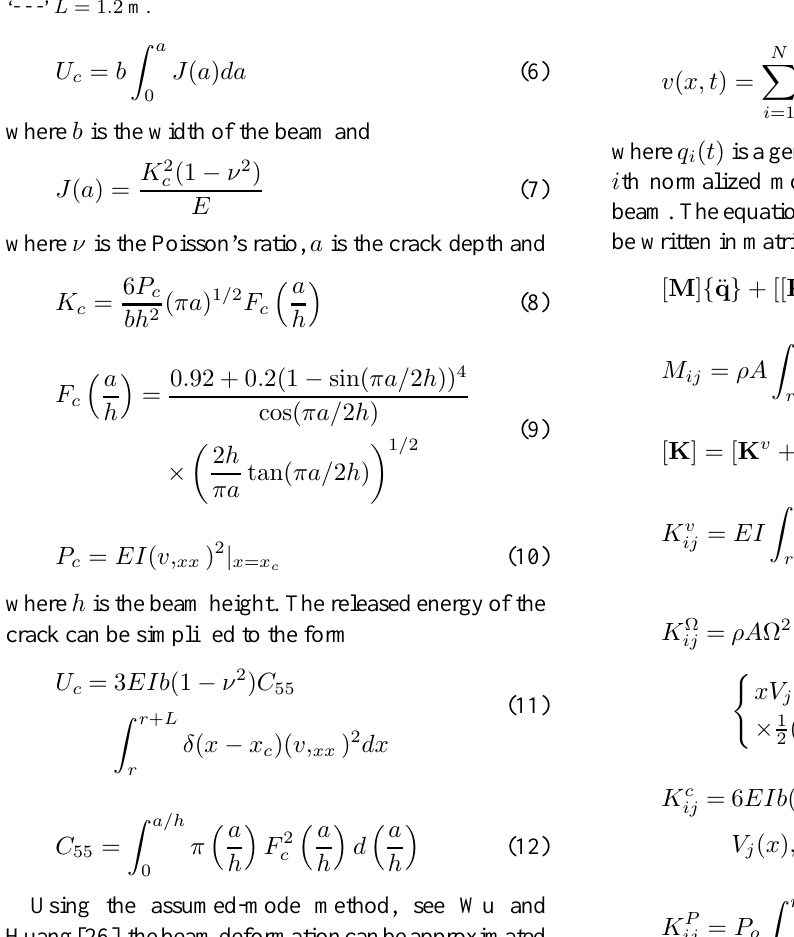
Fig. 2. First two instability regions for a rotating beam with a single crack at mid-span, Ω = 1 and a/h = 0 . 5 . ‘-.-.-’ L = 0 . 8 m, ‘–’ L = 1 . 0 m, ‘- - -’ L = 1 . 2